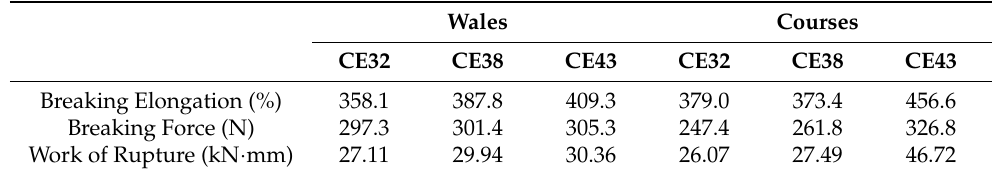
Table 4. Mean values of elongation at break, breaking force, and work of rupture for the knitted fabrics with bare elastane